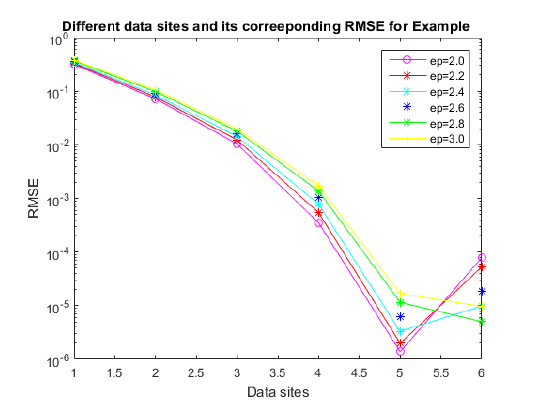
Figure 8. Error Comparison for Example